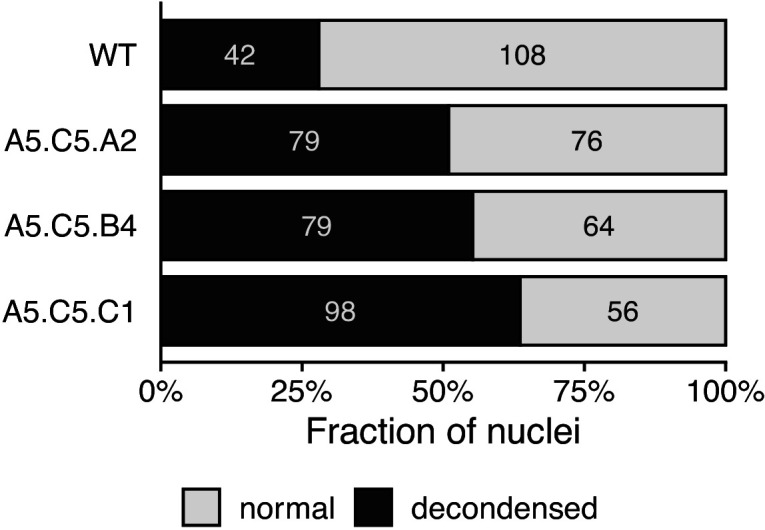
Condensation of chromatin in epiERs.Bar plot showing the fraction of nuclei categorised as decondensed after DAPI staining in wild-type (WT) and epiERs A5.C5.A2, A5.C5.B4 and A5.C5.C1. Number of nuclei for each category in each line shown inside plot.